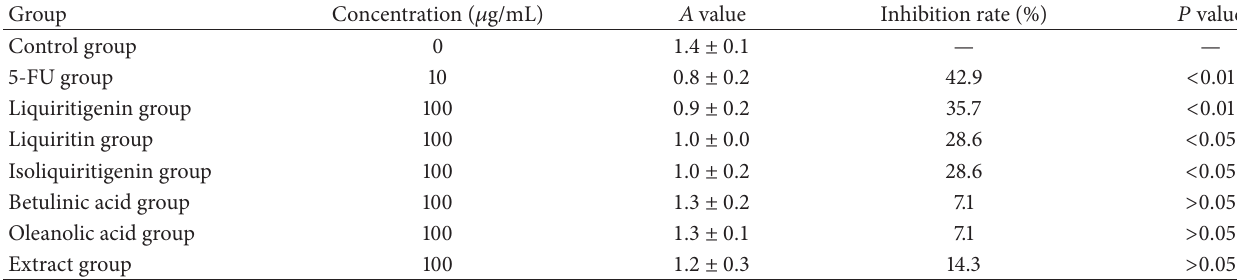
Table 1: Primary hepatoma cell proliferation inhibition rates of various drugs ( 𝑥 ± 𝑠 , %).